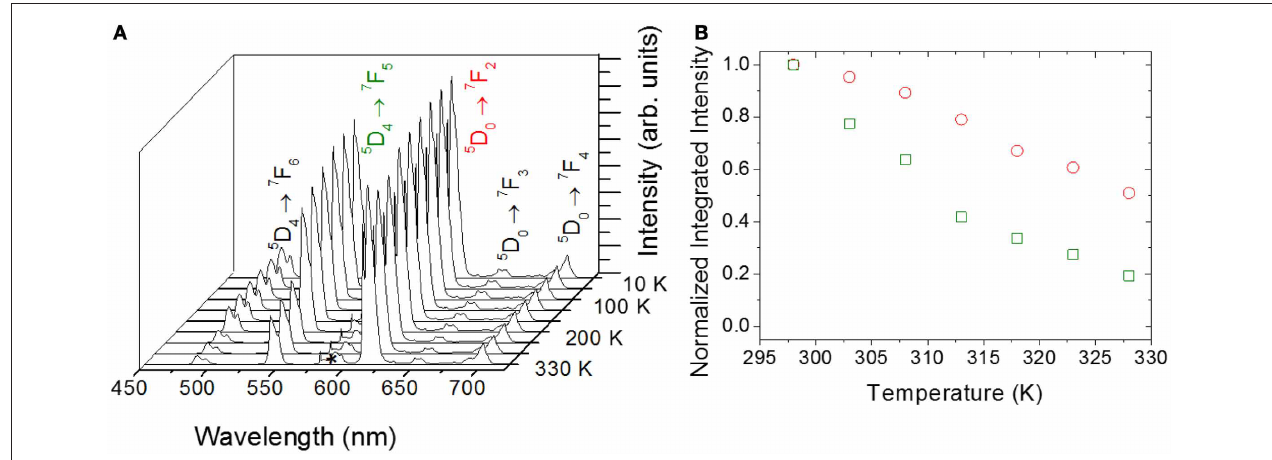
there is a superposition between the emission of Eu 3 + ( 5 D 0 → 7 F 0 , 1 ) and Tb 3 + ( 5 D 4 → 7 F 4 ). (B) Normalized integrated